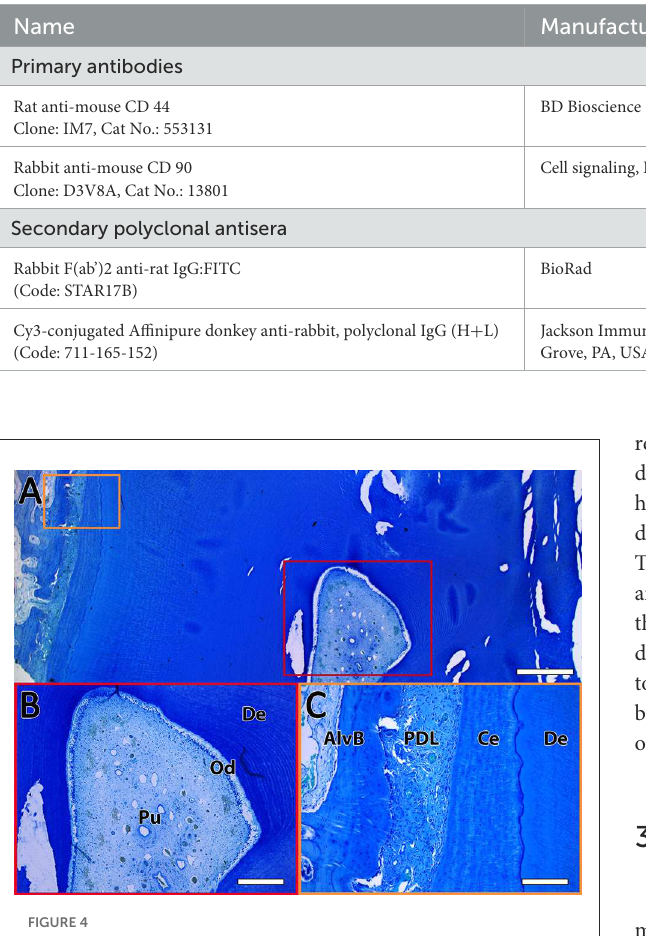
TABLE 4 Antibodies for immunohistochemistry.